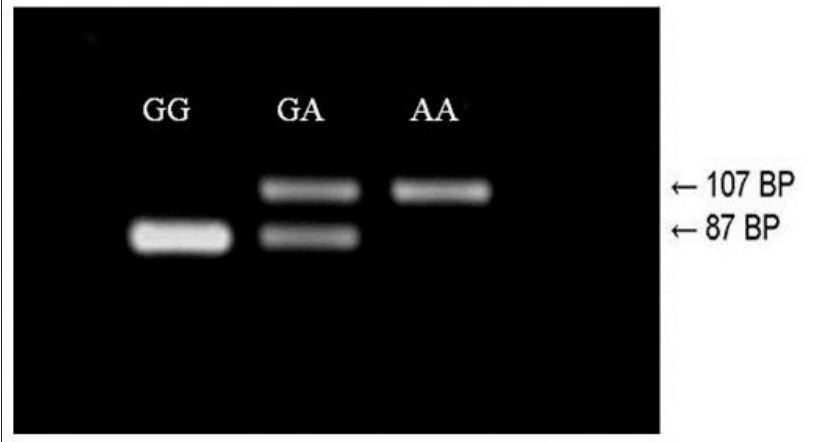
Fig. 1. Restriction fragment length polymorphism (RFLP) showing alleles of the -308 TNF-α promoter polymorphism. The -308 G allele gave rise to a 87 bp and 20 bp fragment, and the -308 A allele to a 107 bp